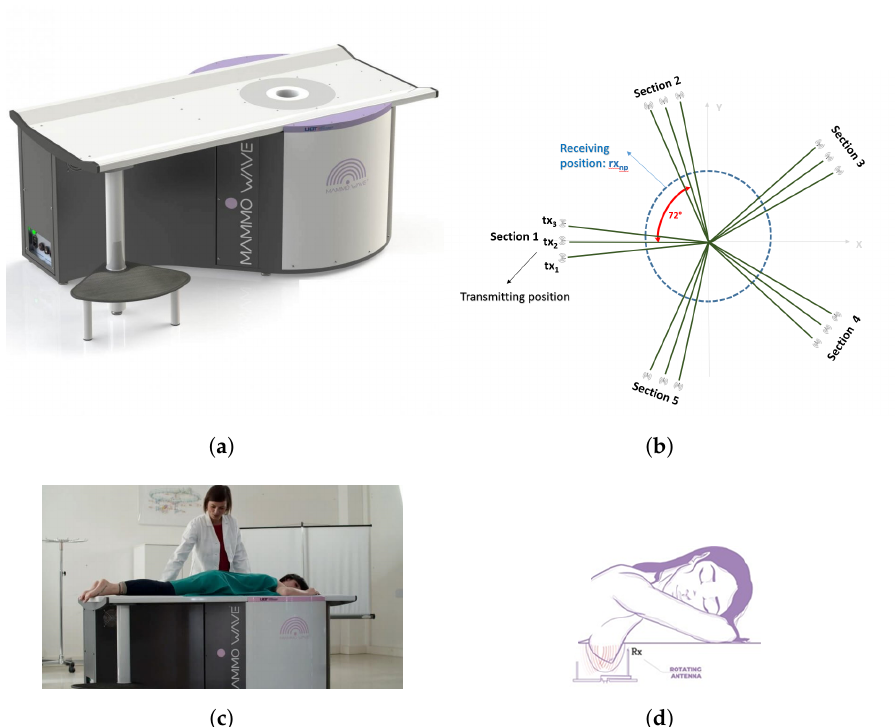
Figure 2. MammoWave device with patient’s position and transmitting-receiving antenna positions. ( a ) Novel MammoWave device. ( b ) Transmitting and receiving antenna rotation positions. ( c ) Patient’s posture over MammoWave. ( d ) Antenna rotation around the